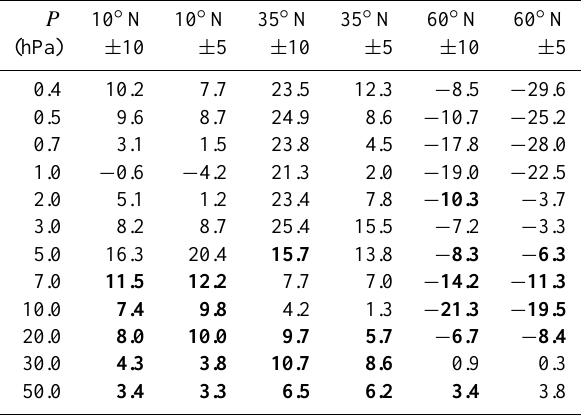
Table 1. Methane trend profiles (%decade − 1 ). Bold denotes trend terms having confidence intervals (CI) ≥